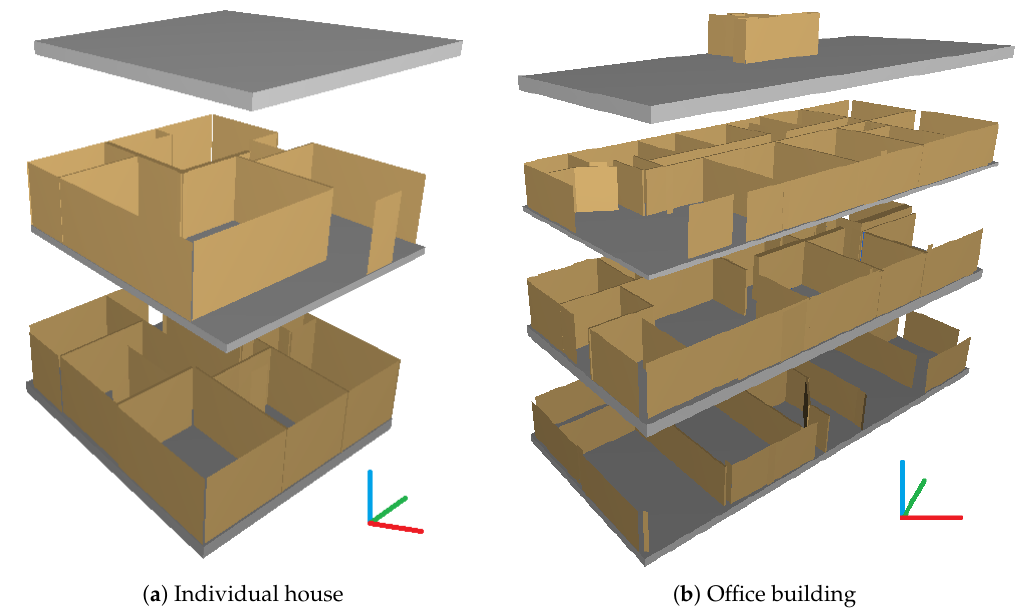
Figure 14. Results of the 3D reconstruction of walls and slabs in an exploded perspective view.